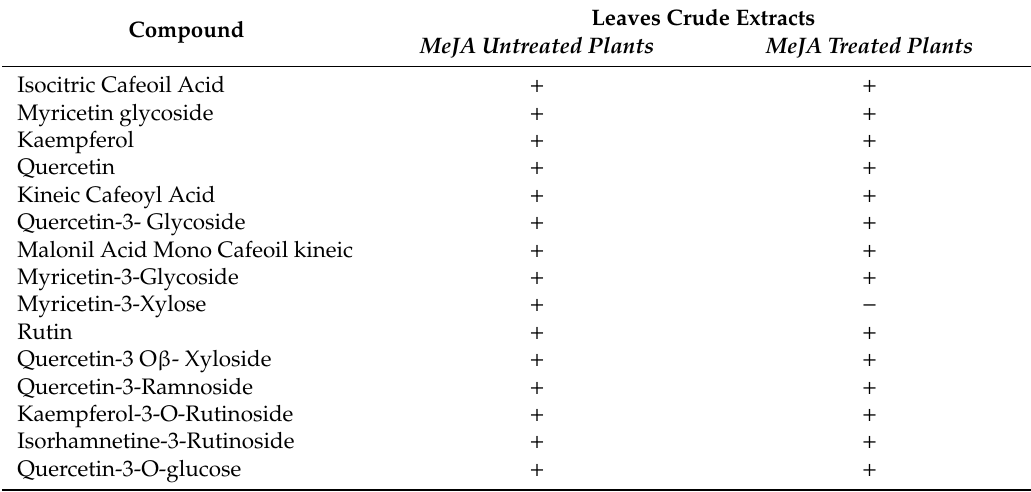
Table 5. Phenolic composition (determined by HPLC / MS / MS) of leaf crude extracts from blueberry plants untreated and treated with MeJA.